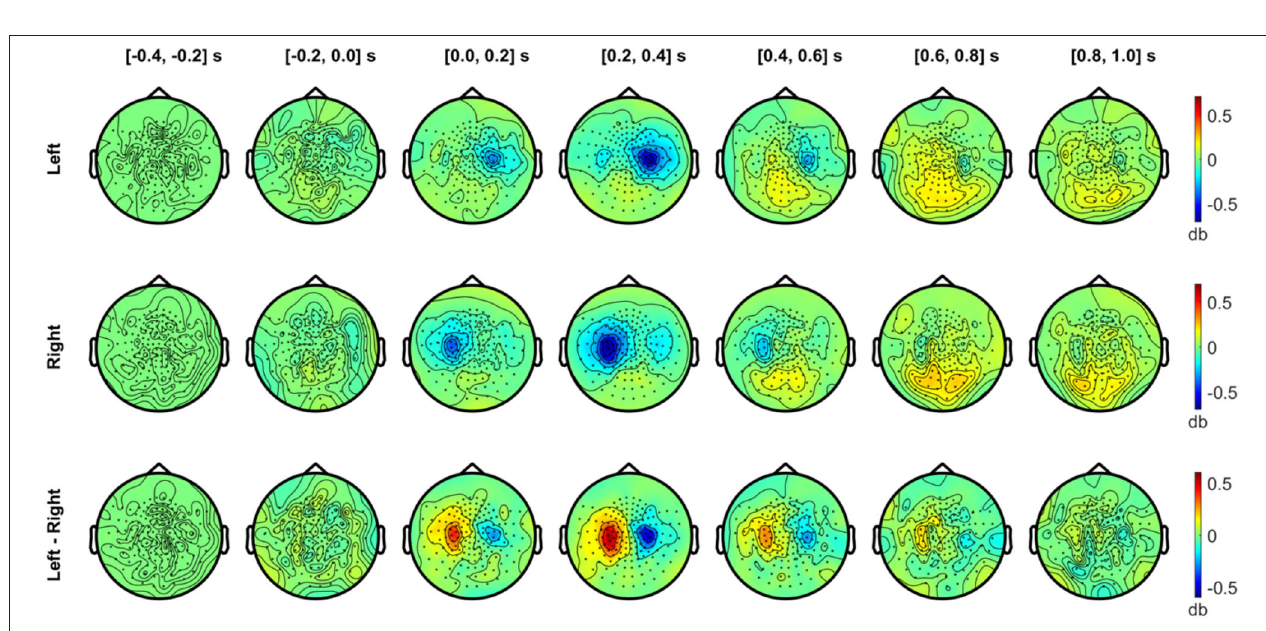
FIGURE 7 | Temporal development of topographical power distributions in the beta band (20–30 Hz) induced by vibrotactile stimulation. The same format as Figure 6 is used but for beta band (20–30 Hz) activity.